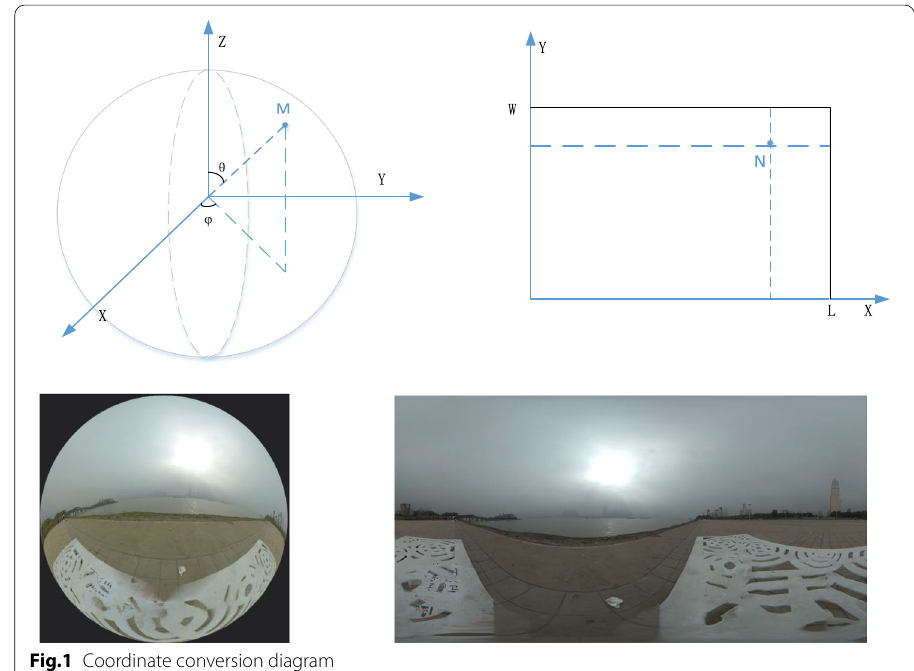
Fig.1 Coordinate conversion diagram